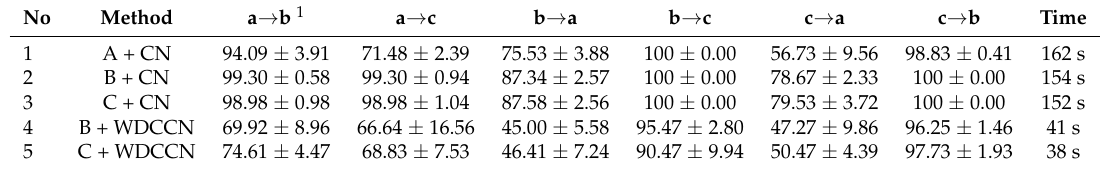
Figure 11. Training process of different models on A-a dataset ( a ) CN and ( b ) WDCNN. Table 4. Accuracies and time of different methods tested at different rotational